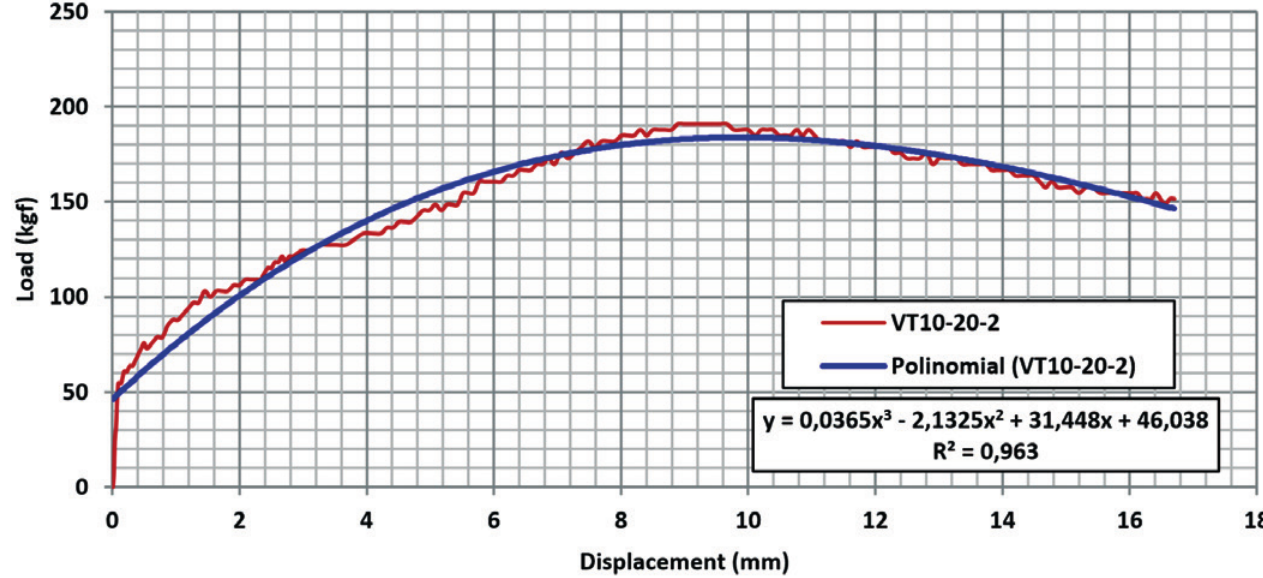
Figure 8 Load versus vertical displacement for the VT 20-30-2 joist (lattice joist 10 cm height; concrete opening of 20 cm; second from the three samples tested under the same